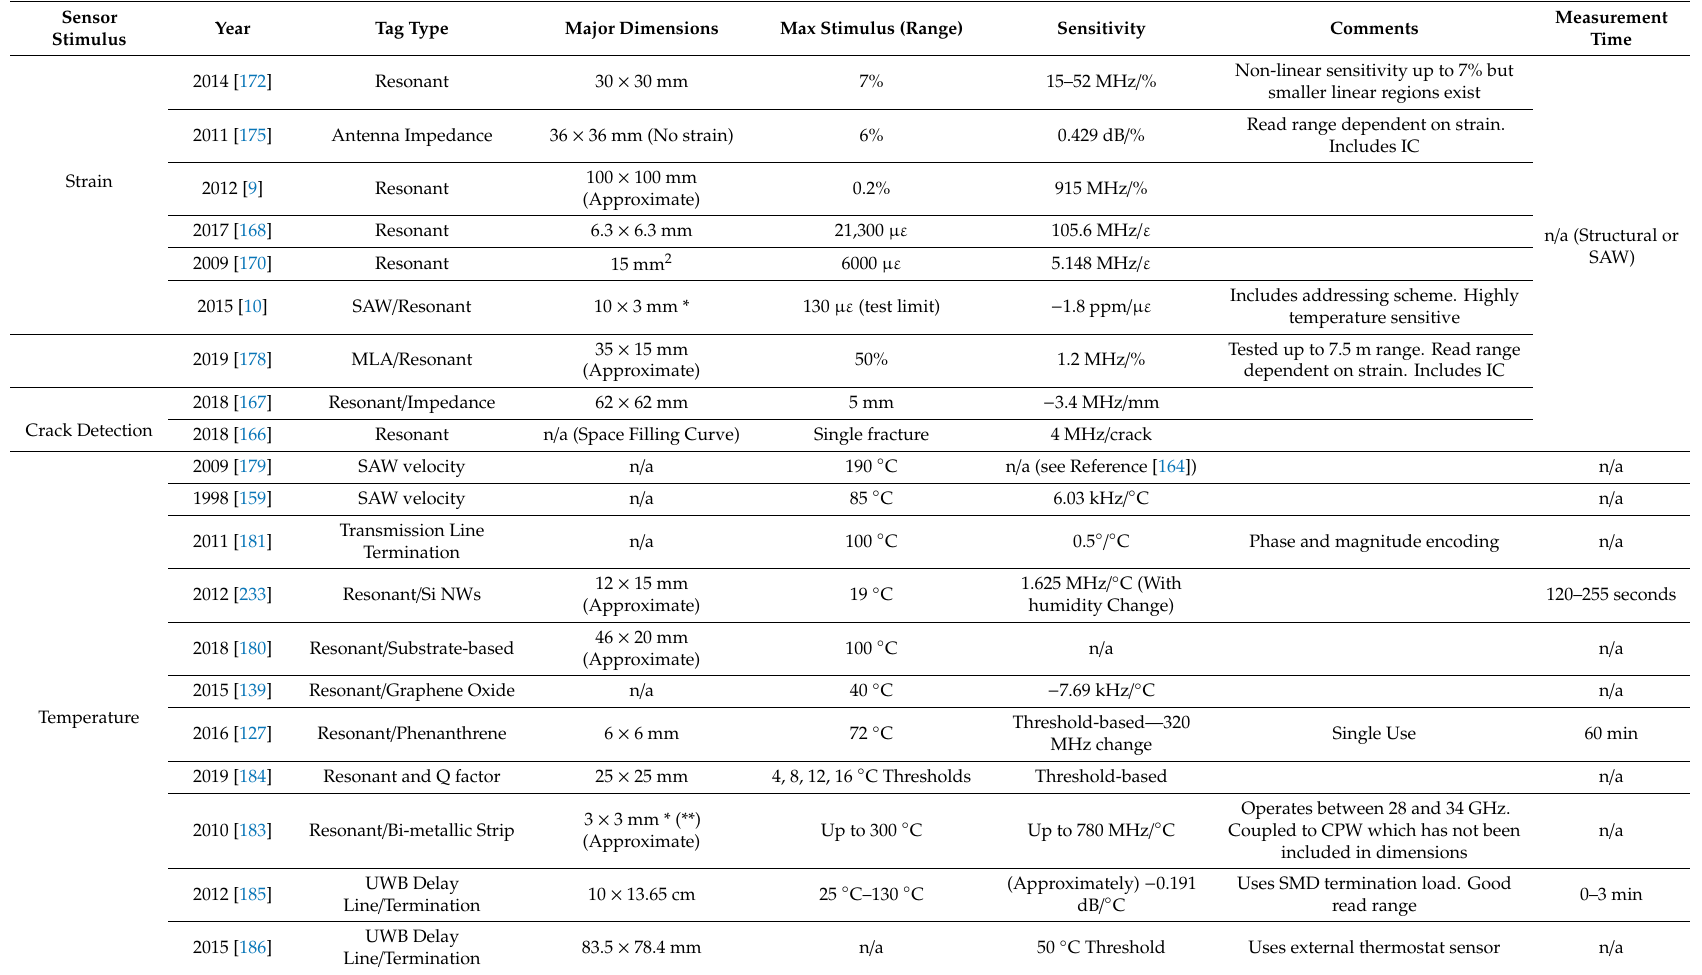
Table 3. RFID Sensor Comparison